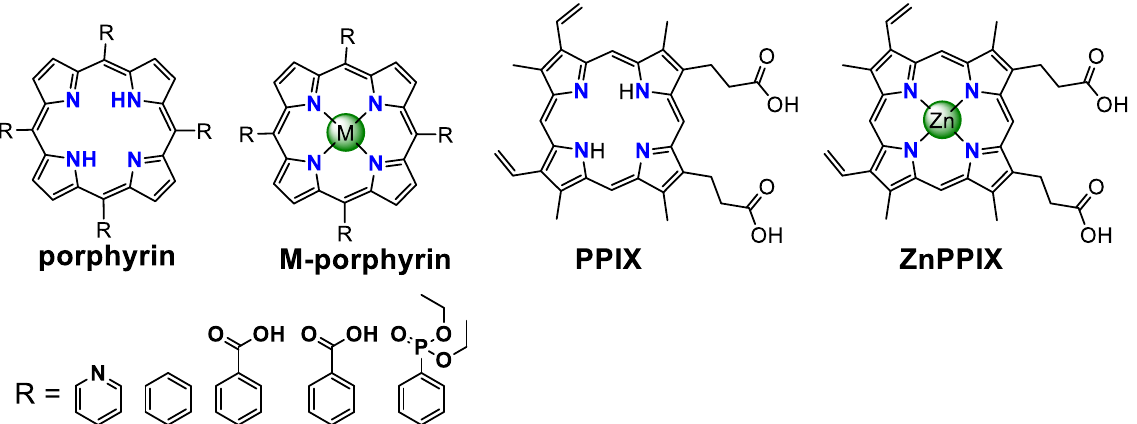
Figure 11. Chemical structures of porphyrin, M-porphyrin (M = Al, Zn, and Sn), protoporphyrin IX(PPIX), and